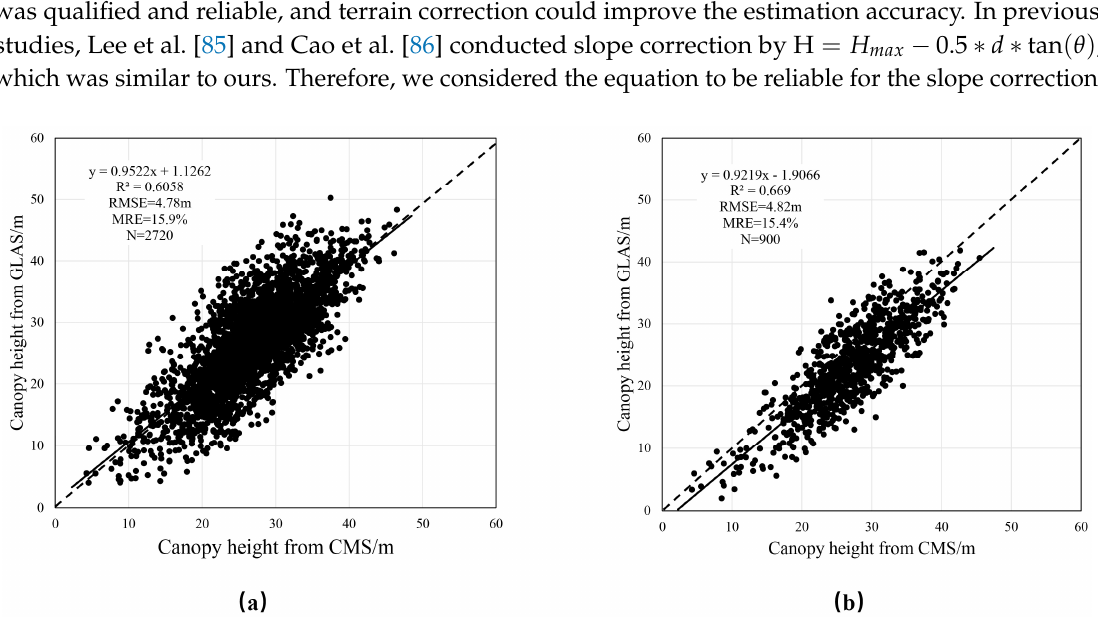
Figure 3. The evaluation of estimated canopy height by the GLAS waveform. ( a ) The evaluation of canopy height without slope correction; and, ( b ) The evaluation of canopy height with slope correction.